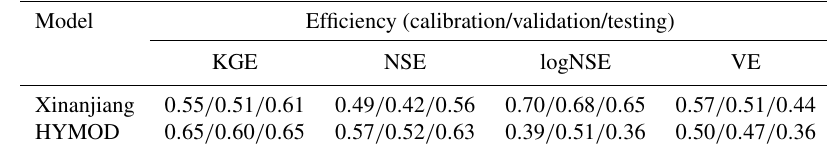
Table 7. Performance matrix of Xinanjiang model and HYMOD model.